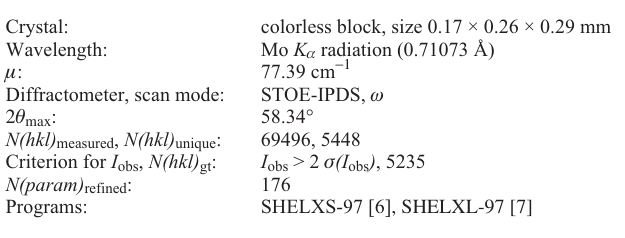
Table 1. Data collection and